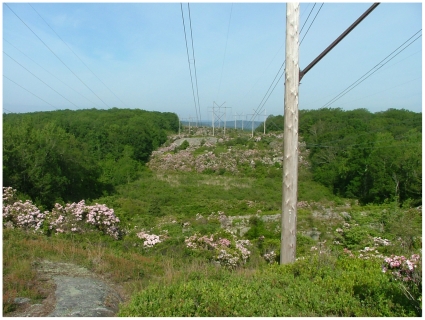
Powerline corridor managed by selective removal of trees to maintain low vegetation in Montville, Connecticut, U.S.